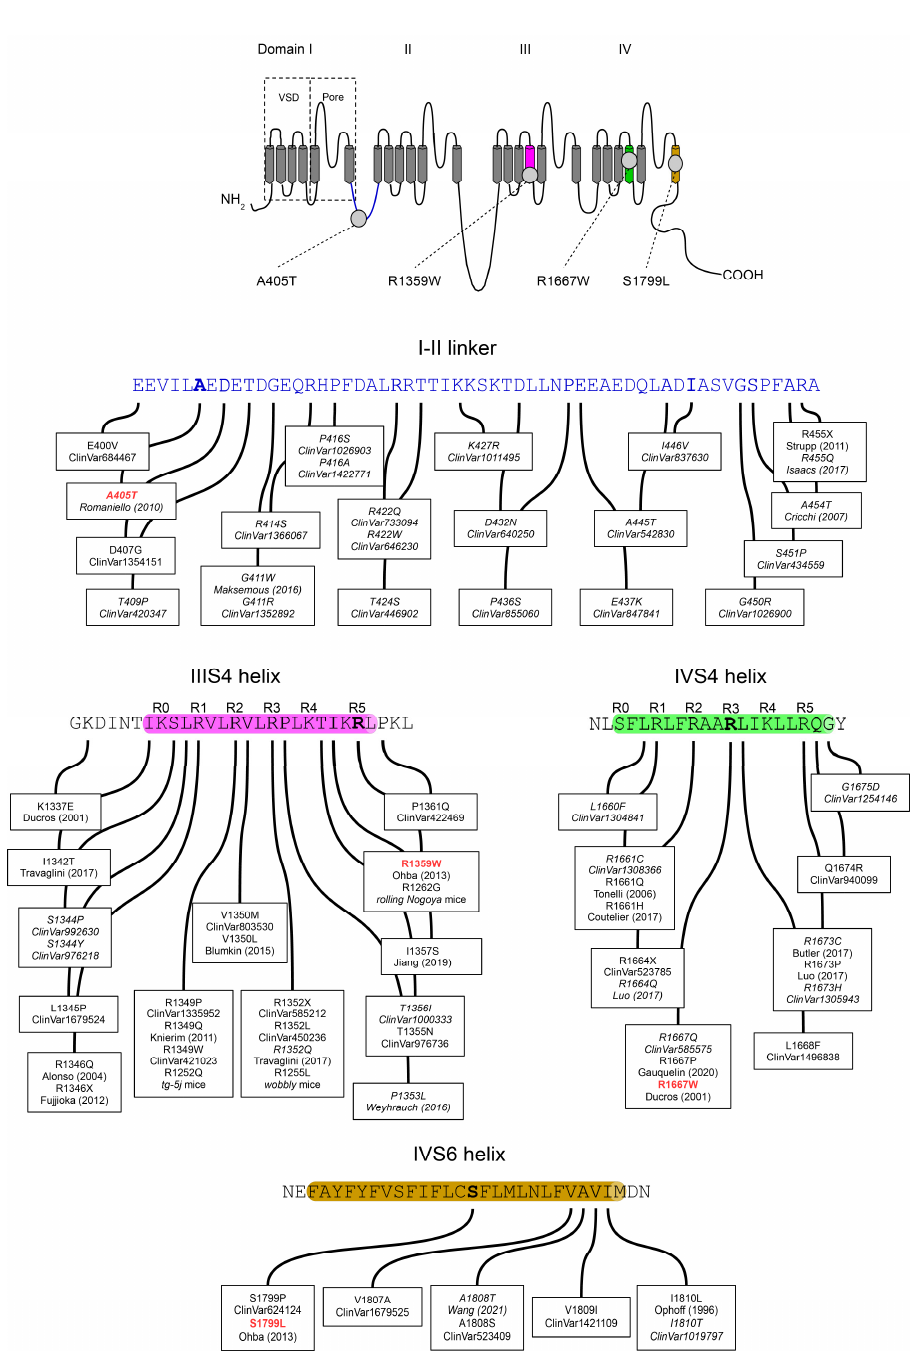
Figure 1. ( Top ) Topology of the voltage-gated Cav2.1 subunit with the position of the four pathogenic variants studied: A405T, R1359W, R1667W, and S1799L. The Cavα is formed of four repeats (I to IV) each containing 6 transmembrane helices (S1–S6). The S1–S4 helices constitute the voltage-sensing domain (VSD) able to move in response to membrane potential changes. The four re-entrant P loops between segments S5 and S6 carry the selectivity filter and delineate the extracellular end of the channel pore. The S5 and S6 helices of the four repeats delineate the cytoplasmic end of the channel pore. ( Bottom ) Amino-acid sequences of the I-II loop, and of the IIIS4, IVS4, and IVS6 helices. Cav2.1 variants referenced in the NCBI ClinVar database are indicated with their accession number. References in italics correspond to variants ‘of uncertain significance’ when subjected to in silico analysis. The ‘R’ above the sequences of the IIIS4 and IVS4 helices indicates the position of a basic residue. The Cav2.1 sequence is numbered according to the NCBI Genbank ® sequence